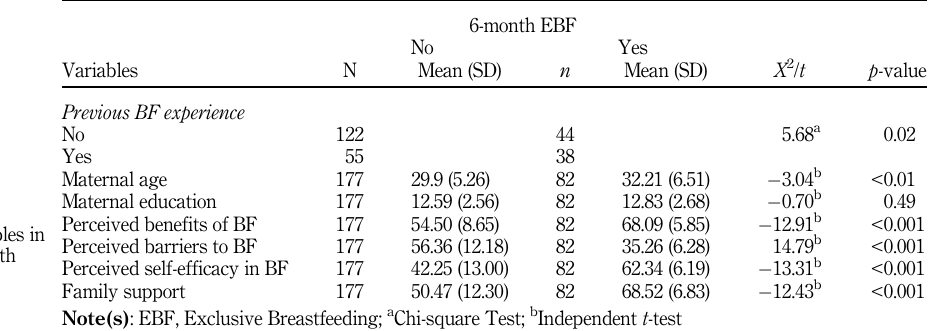
relation to 6-month